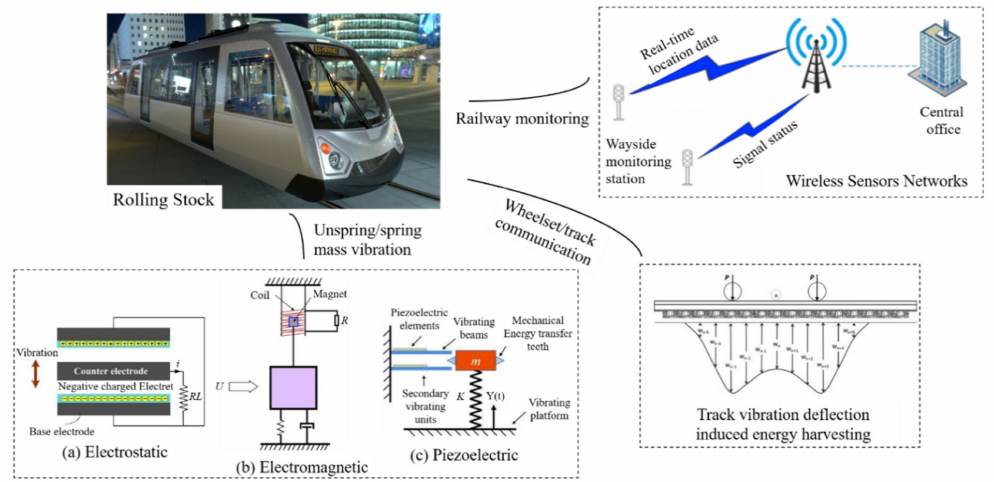
Figure 1. Illustration of energy harvesting applied to the railway industry, adopted from